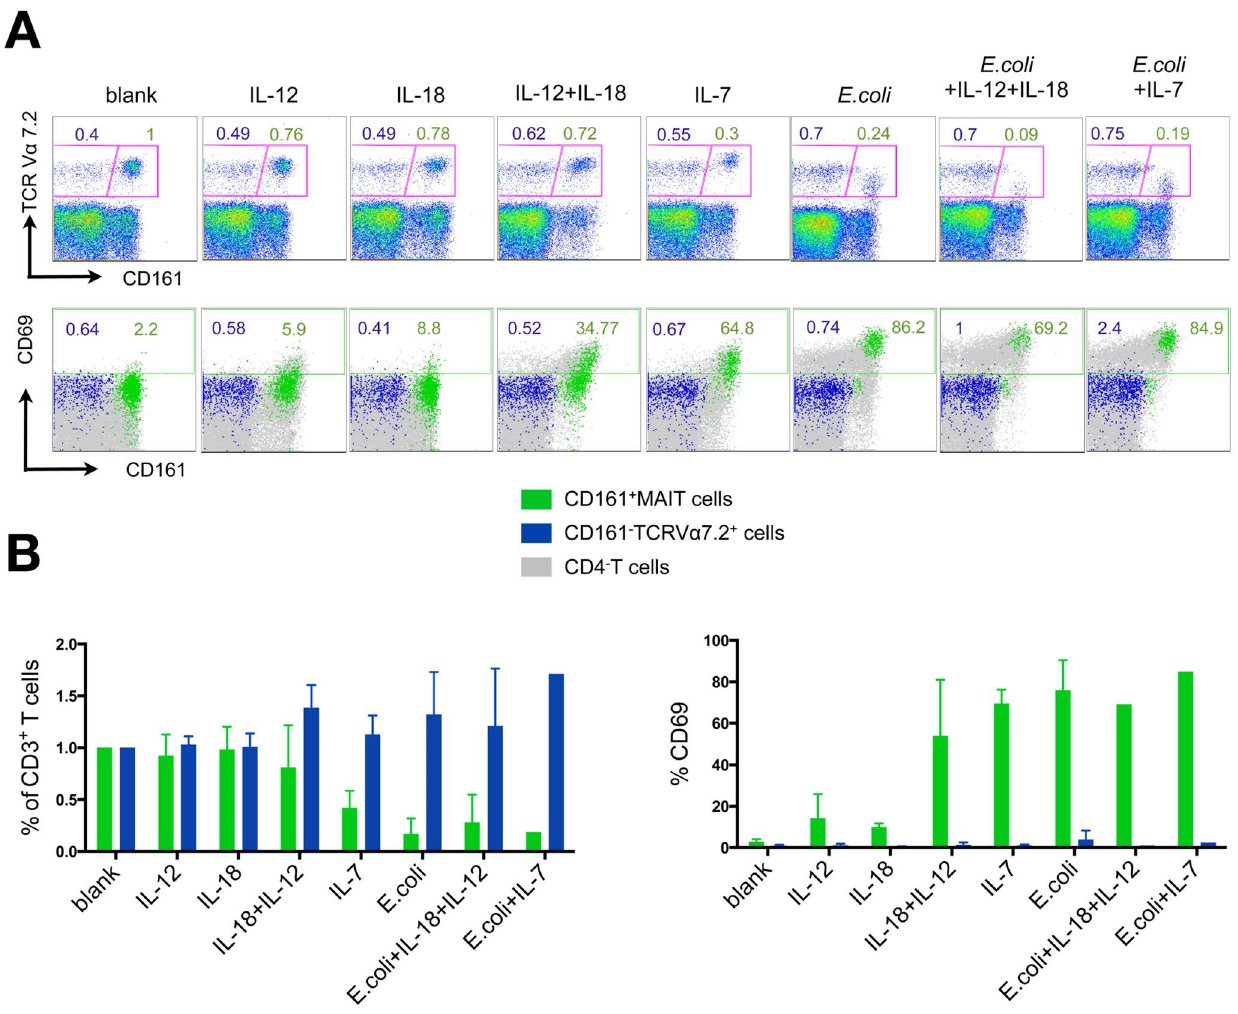
Figure 4. Frequencies of CD161 + MAIT cells are reduced upon invitro stimulation with PFA fixed E.coli , IL-7 and combined IL-12 and IL-18. A ) Representative FACS plots depicting frequencies of CD161 – TCRV a 7.2 + cells, CD161 + MAIT cells and all TCRV a 7.2 + cells as frequencies of CD3 + T cells after 28 hours of stimulation with IL-12 (100 m g/ml), IL-18 (100 m g/ml) and their combination, IL-7 (100 m g/ml) and PFA fixed E. coli (bacteria per cell ratio of 100:1 PBMC). PBMCs were healthy donor-derived and seeded in 1 6 10 6 cells/well. B ) Cumulative display of normalized frequencies of CD161 + MAIT cells and CD161 – TCRV a 7.2 + cells from 3 healthy donors in duplicate measurements for each stimulation setting (apart from E.coli in combination with cytokines, which was tested once) measured after 28 hours of stimulation (left panel). Activation levels were assessed by determining the percentage of CD69 + cells within the CD161 + MAIT cell and the CD161 – TCRV a 7.2 + population. anti-CCR6 (G034E3) (from Biolegend or BD Biosciences, Heidelberg, Germany) for 20 min at RT in the dark. After surface staining, cells were washed once with PBS and were then resuspended in 0.5% paraformaldehyde. For intracellular cytokine staining, the cells were stimulated with PMA (50 ng/ml) and ionomycin (0.67 m M) for 5 h at 37 u C and 5% CO 2 prior to the last 4 h of the stimulation. Data were collected on a BD LSRII Germany).